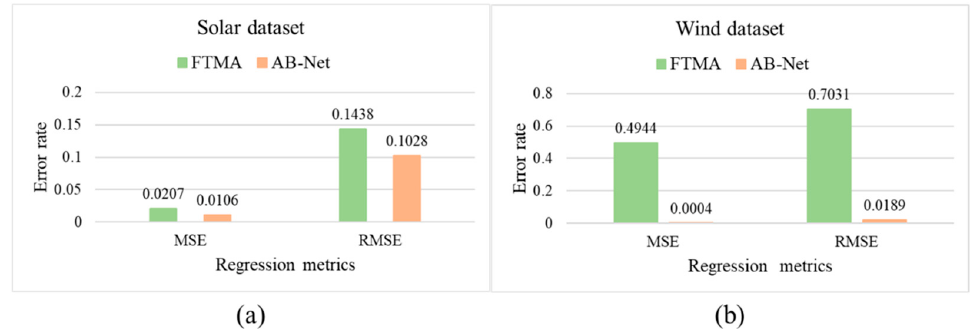
Figure 9. Comparative analysis of the proposed method with existing state-of-the-art method: ( a ) represents the comparison result on the solar dataset, while ( b ) represents the result on the wind dataset.